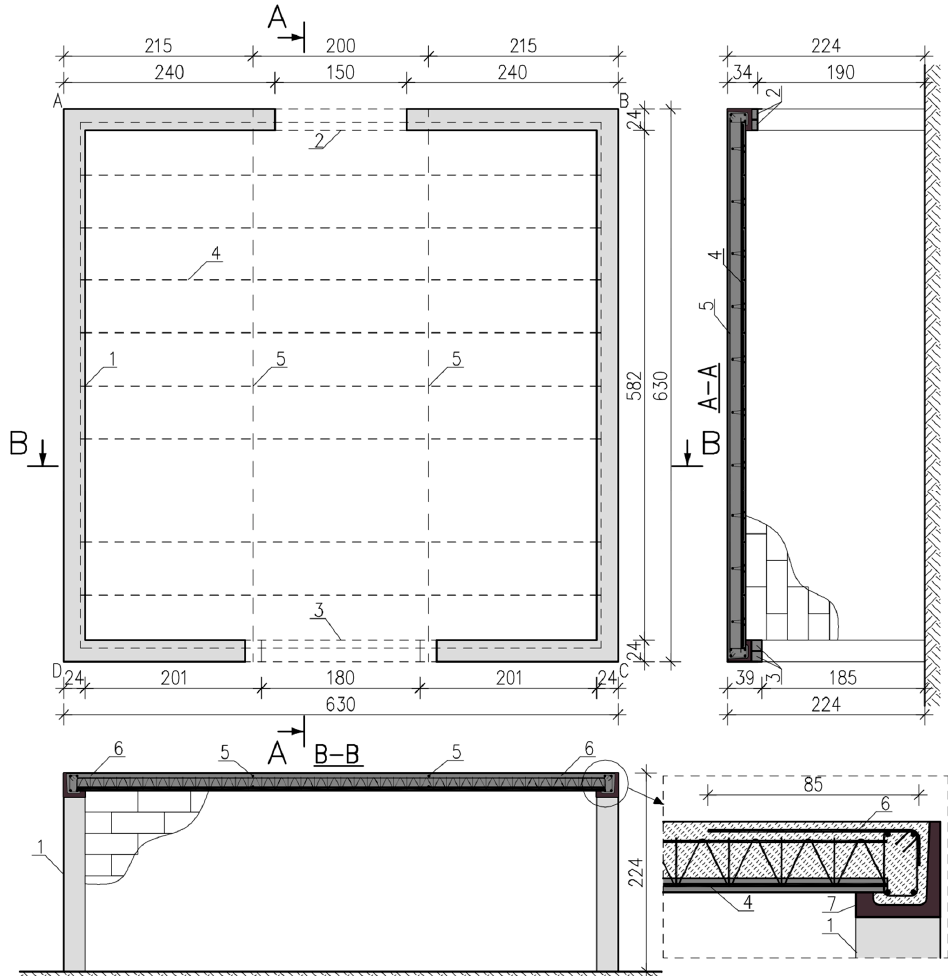
Figure 3. Geometric dimensions: top view, A–A cross-section, B–B cross-section (1—wall, 2—lintel 2 × SBN 7, 2/12/210, 3—lintel 2 × SBN 12/12/180, 4—lattice girder panel, 5—distribution ribs, 6—support reinforcement, and 7—precast bond beam form).